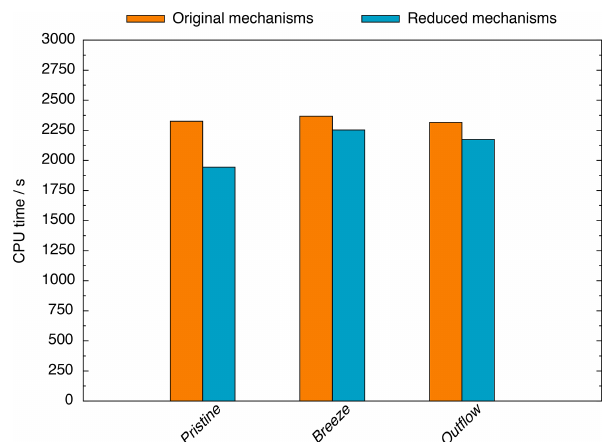
Figure 2. Required CPU time within the pristine , breeze , and outflow scenarios considering the original multiphase chemistry mechanism system MCMv3.2/CAPRAM4.0/CAPRAM- DM1.0/CAPRAM-HM3.0 and the multiphase chemistry mecha- nism system with CAPRAM-DM1.0red and CAPRAM-HM3.0red. The CPU costs include gas- and aqueous-phase chemistry, micro- physics, model initialization, and